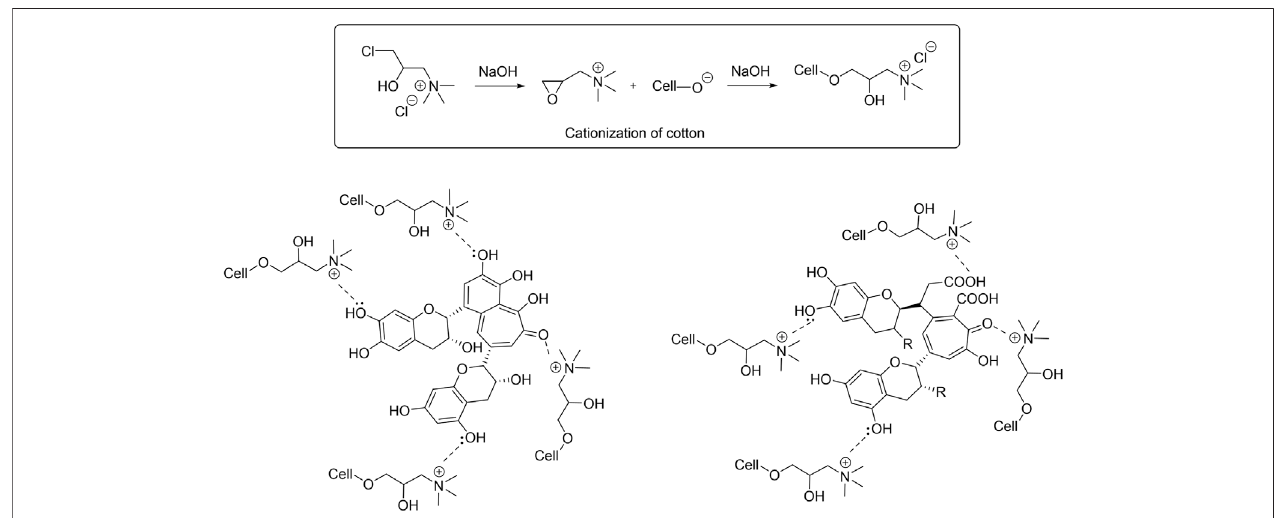
FIGURE 7 | Probable interaction of cationized cotton with black tea